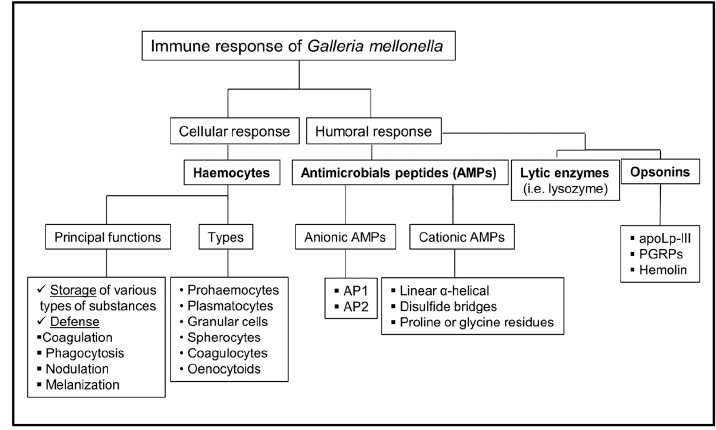
Figure 1. Scheme of the immune response of Galleria mellonella. PGRPs: Peptidoglycan recognition proteins; AMPs: antimicrobial peptides.